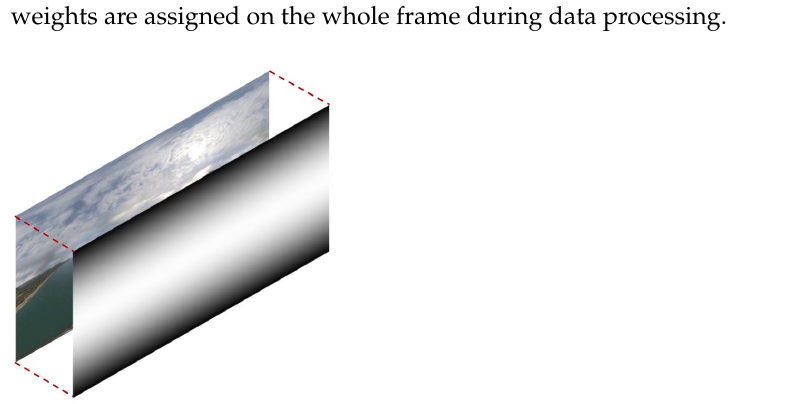
Figure 5. The weight diagram of the loss